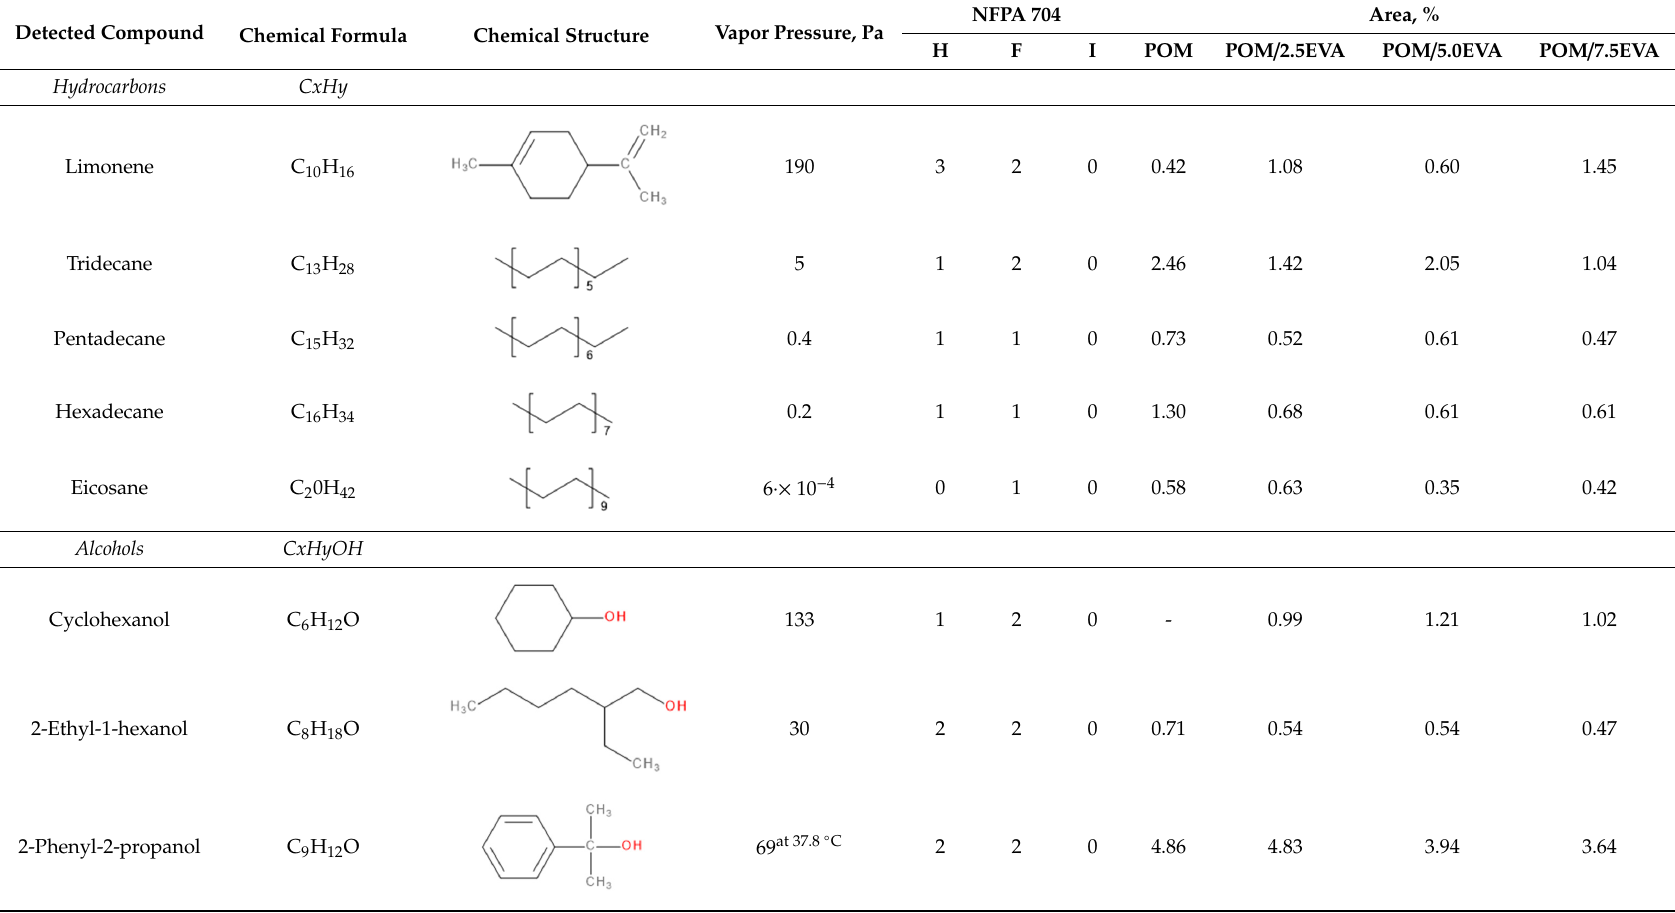
Table 4. Chemical compounds detected by headspace analysis of investigated POM/EVA blends and neat POM. 1 Detected Compound Chemical Formula